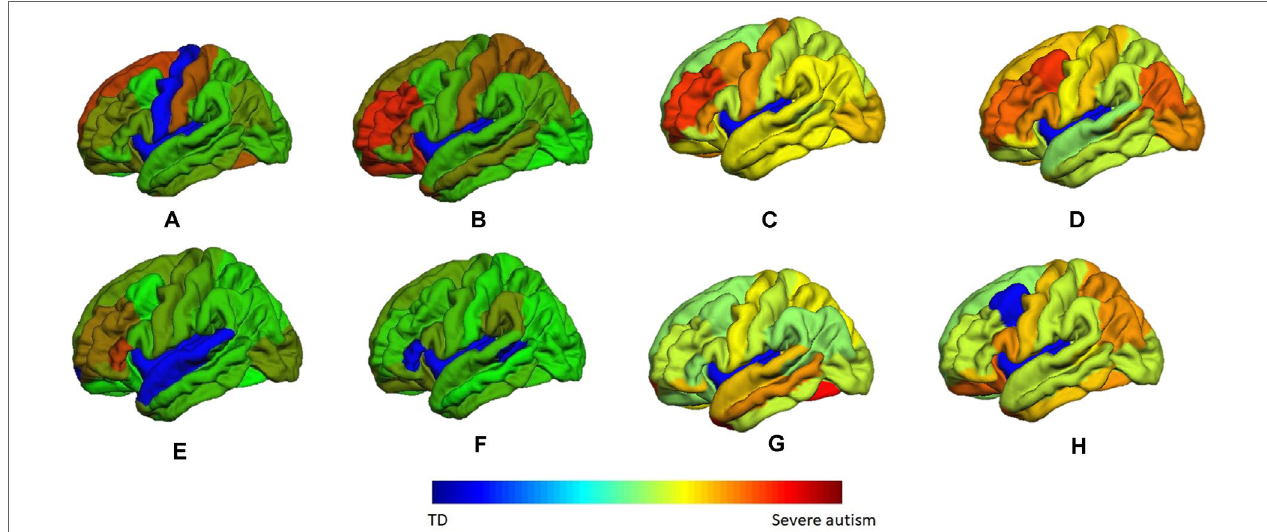
FIGURE 10 | A sample of the generated personalized maps for eight subjects: (A, B) are the personalized maps of two ASD subjects obtained from sMRI local classification, (C, D) are the personalized maps of two ASD subjects obtained from fMRI local classification, (E, F) are the personalized maps of two TD subjects obtained from sMRI local classification, and (G, H) are the personalized maps of two TD subjects obtained from fMRI local